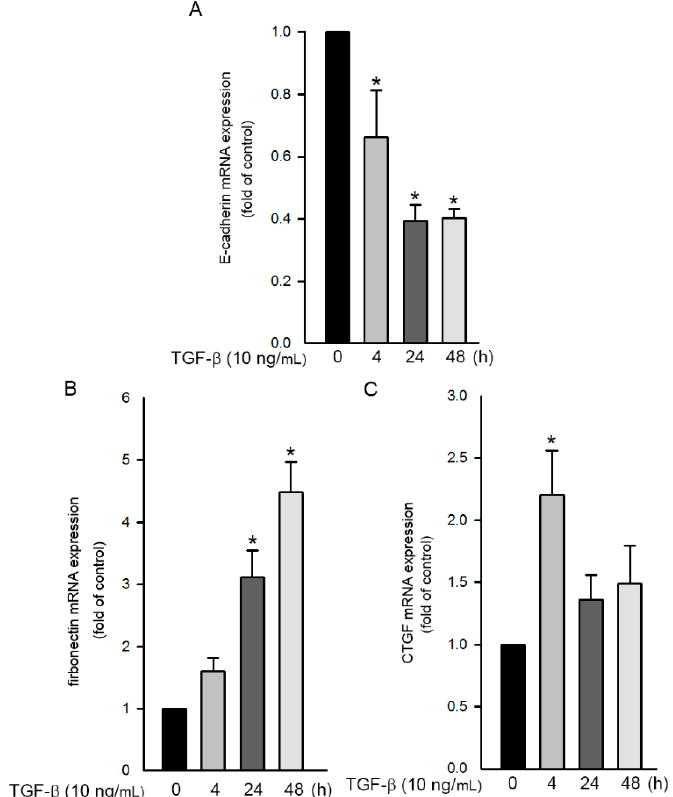
Figure 7. TGF- β -induced change in EMT-related mRNA levels in human lung epithelial A549 cells. ( A ) Cells were stimulated with TGF- β (10 ng/mL) for 0–48 h. Total RNA was isolated and